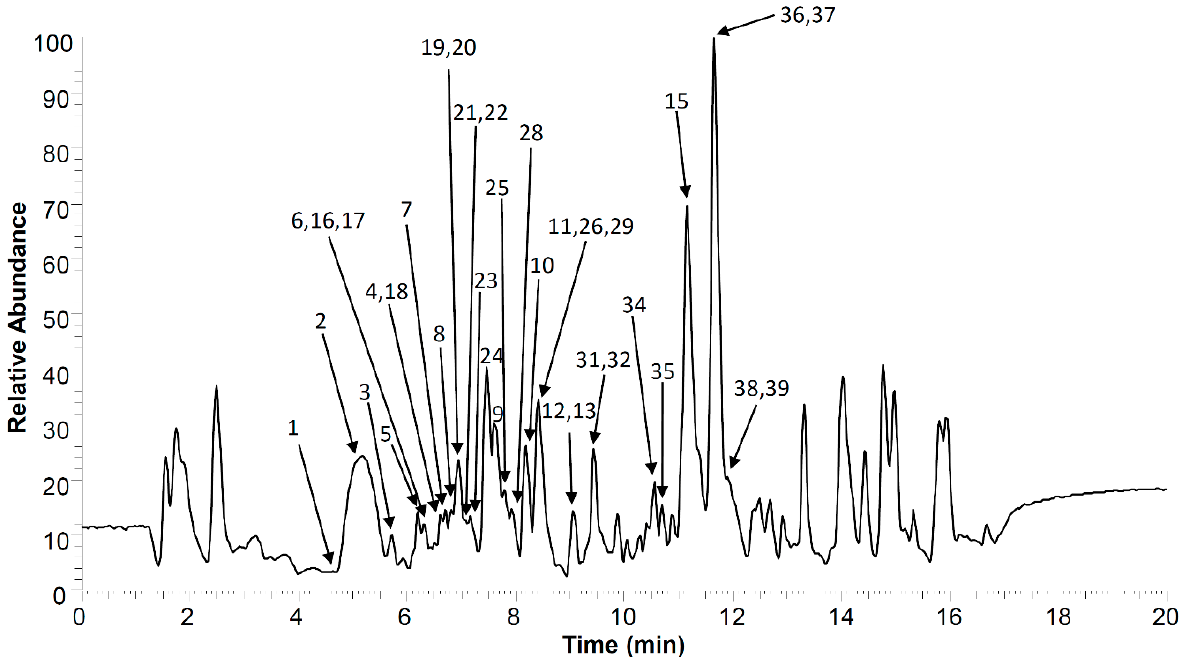
Figure 2. UHPLC-MS 4 Orbitrap chromatogram (negative ionization mode) of R. holostea aerial part methanolic extract. Compounds 14 , 27 , 30 and 33 are not visible in this plot, as their peaks are below the baseline.